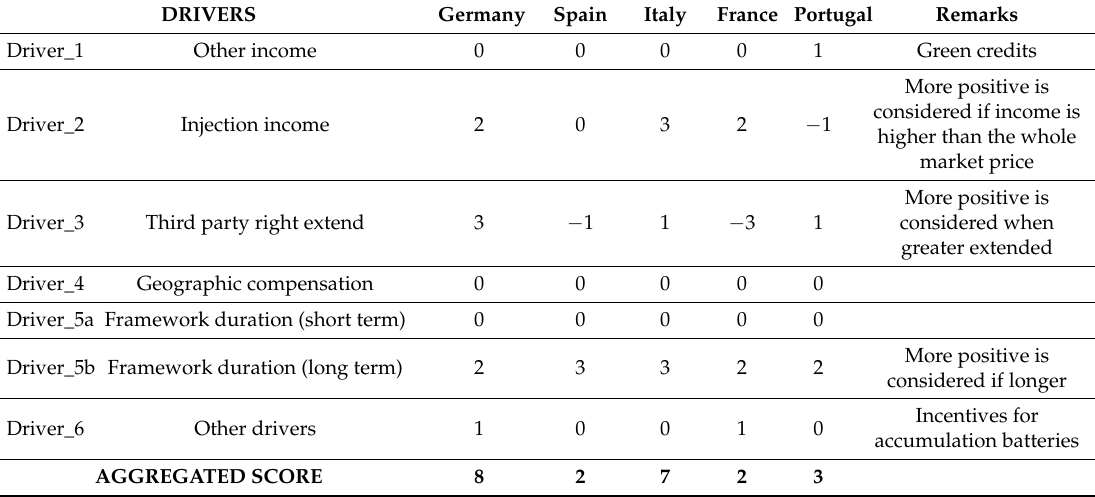
Table 1. Regulation impact on the set of drivers for self-consumption. DRIVERS